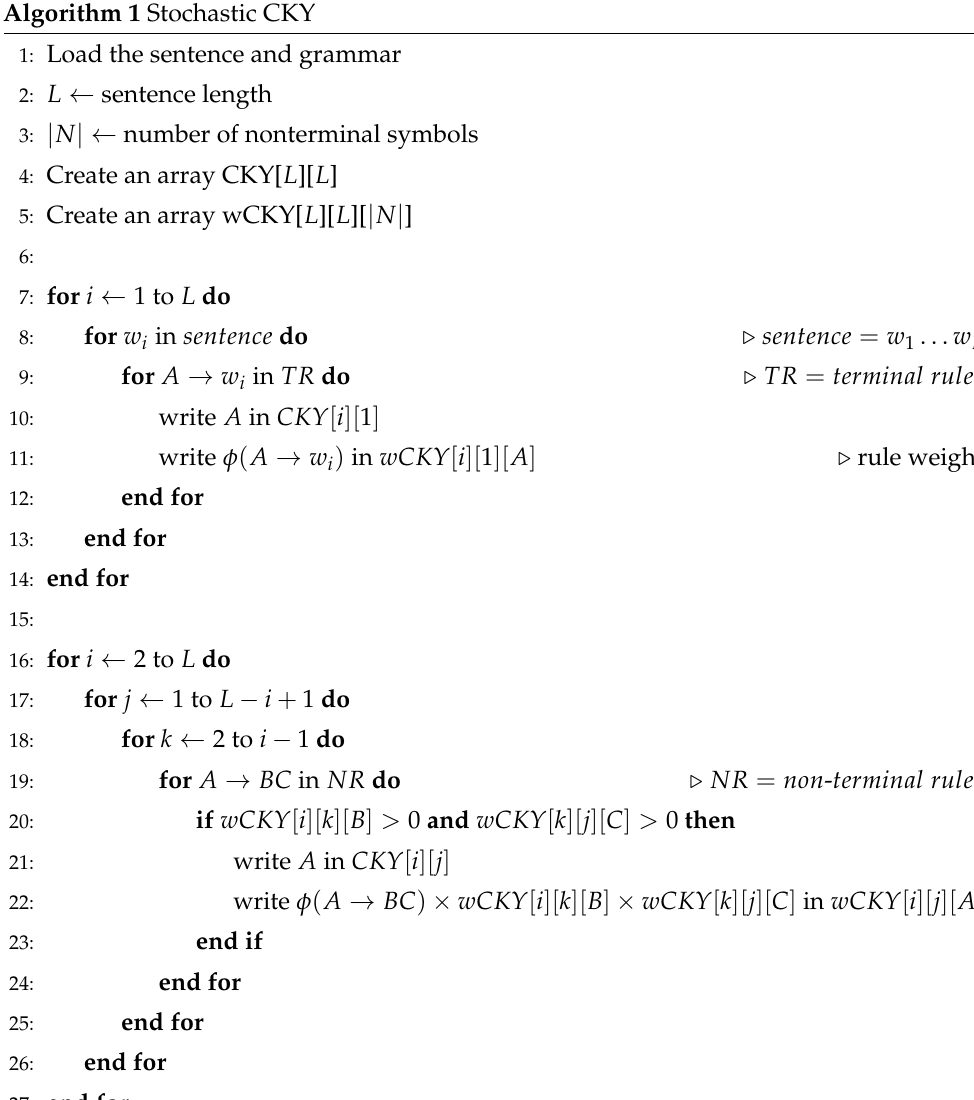
Algorithm 1 Stochastic